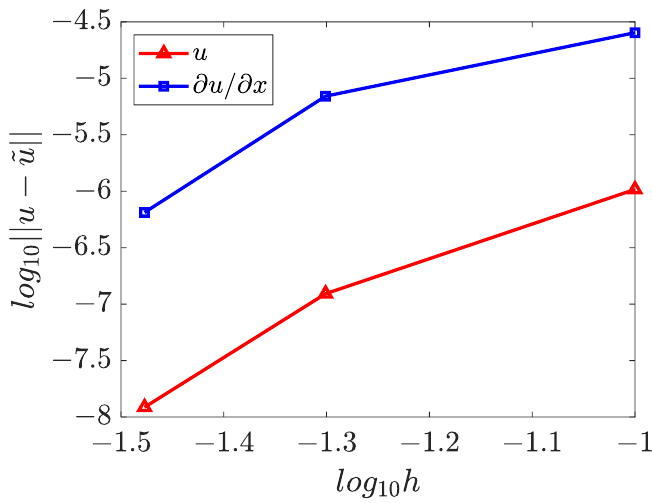
Figure 3. Convergence of the solutions for the 1D constant parameter identification problem.